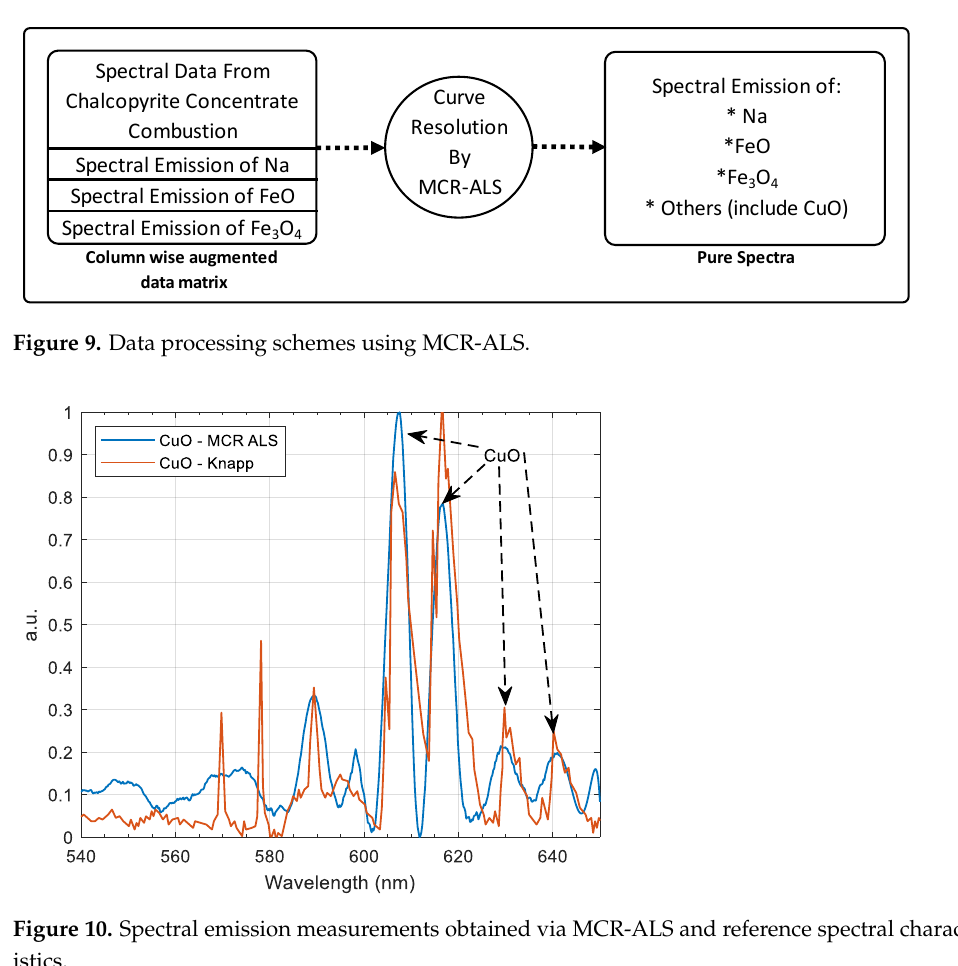
Figure 10. Spectral emission measurements obtained via MCR-ALS and reference spectral charac- teristics.